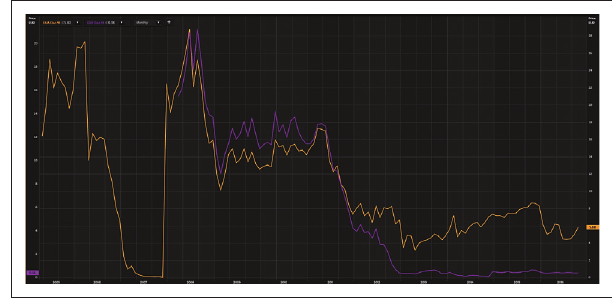
Source : Figure generated in Thomson Reuters Eikon 2016 FIGURE 5: Line graph showing the average monthly price of European Union Allowance futures (in orange) and Certified Emission Reductions futures (in purple) being traded on the European Climate Exchange, both expiring in December 2016, in €/tCO e between April 2005 and October 2016. 2